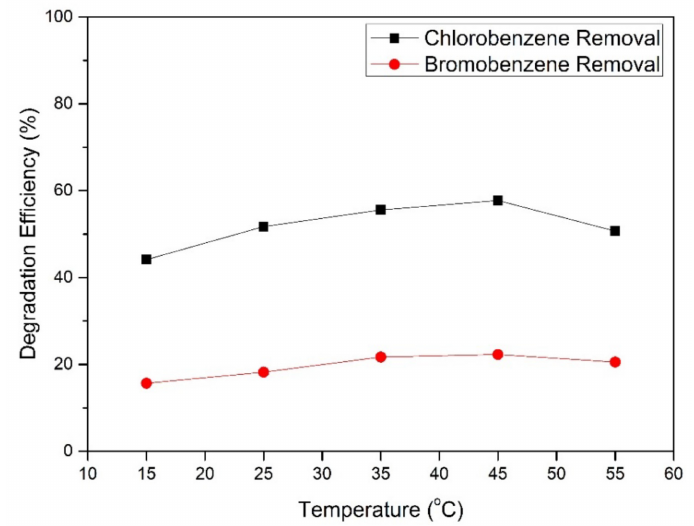
Figure 7. Effect of temperature on the removal of HBD by ferrate(VI). (Experimental conditions: C o = 0.010 mM, [FeO 4 2 − ] = 0.020 mM, initial pH =